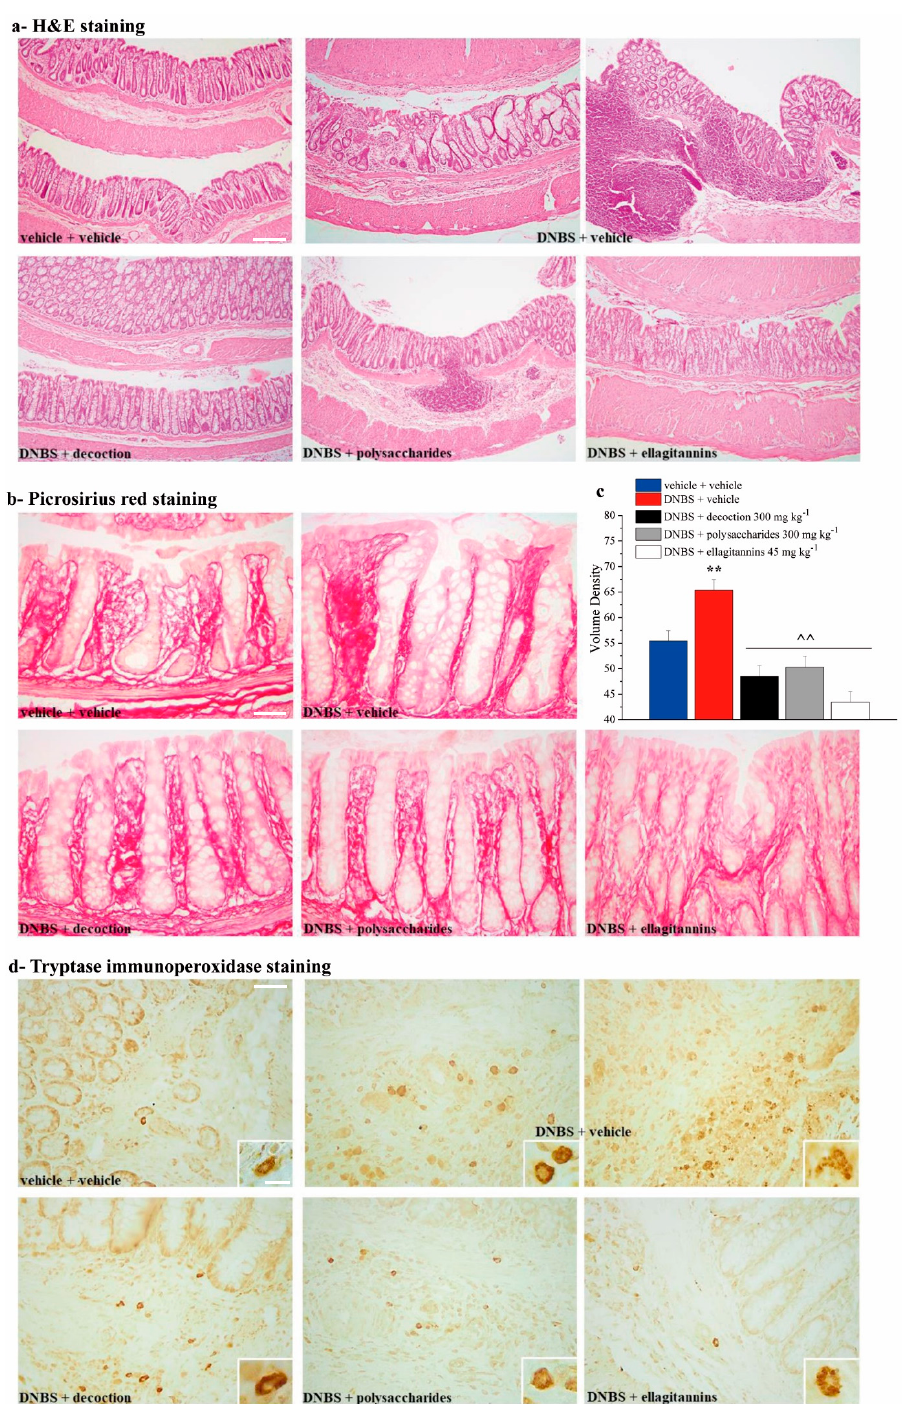
Figure 5. E ff ect of repeated treatment with pomegranate-based preparations on colon microscopic damage. Microscopic evaluations were carried out 14 days after DNBS injection by light microscopy on sections of colon. Histological evaluations were performed on sections stained with hematoxylin and eosin ( a , scale bar: 20 × ), picrosirius red staining ( b , scale bar: 40 × ), and tryptase immunohistochemistry ( d , scale bar: 40 × , insert: 100 × ). For picrosirius red analysis, a morphometric quantitative evaluation of the staining intensity (expressed as volume density) was performed on the digital images ( c ). The reported values are the means ± SEM of the measurements of individual animals (at least five images each) from the di ff erent experimental groups. ** p < 0.01 vs. vehicle + vehicle group. ˆˆ p < 0.01 vs. DNBS + vehicle